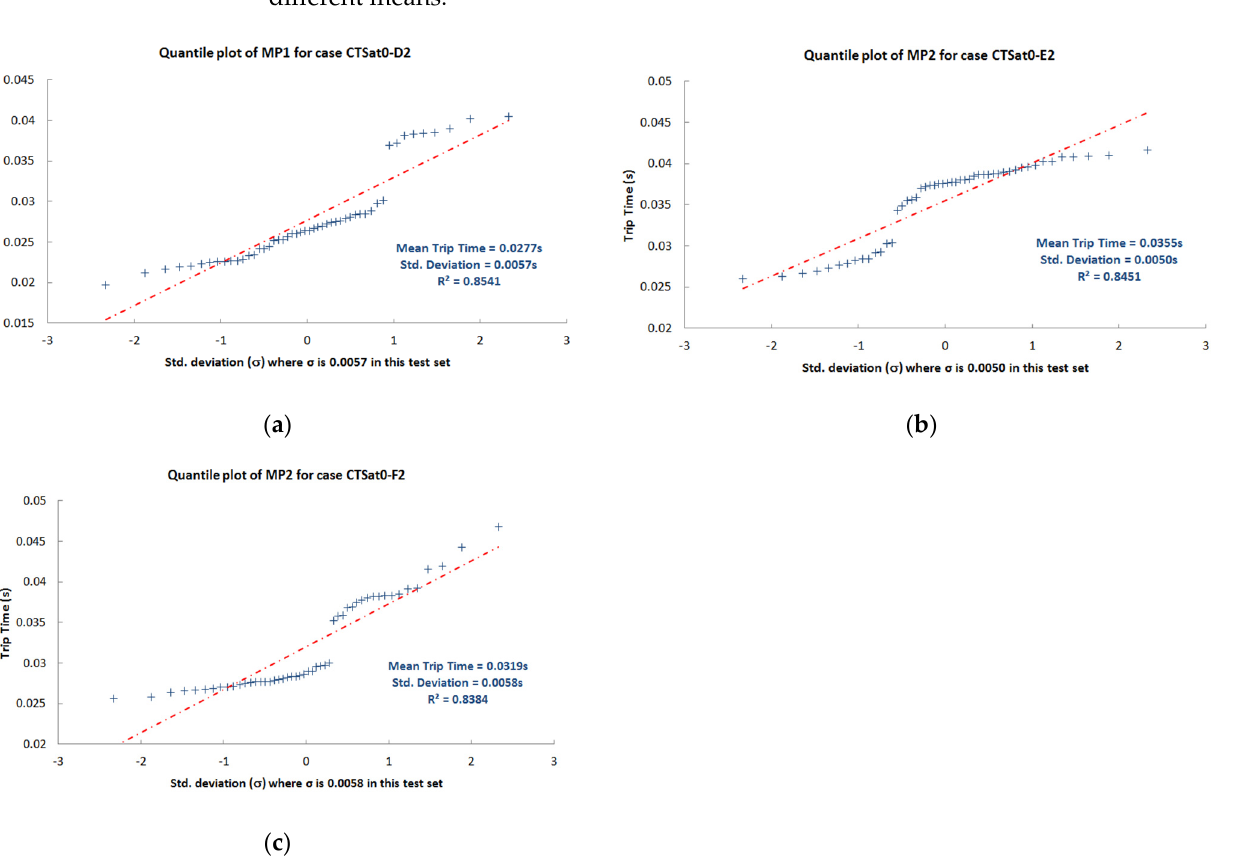
Figure 28. Quantile plot for cases: ( a ) CTSat0-D2 (ideal CT, no faulty device, 1Ph-G fault at 70% of the feeder); ( b ) CTSat0-E2 (ideal CT, 1 faulty AMU, 1Ph-G fault at 70% of the feeder); and ( c ) CTSat0-F2 (ideal CT, 1 faulty AMU+ 1 faulty fibre, 1Ph-G fault at 70% of the